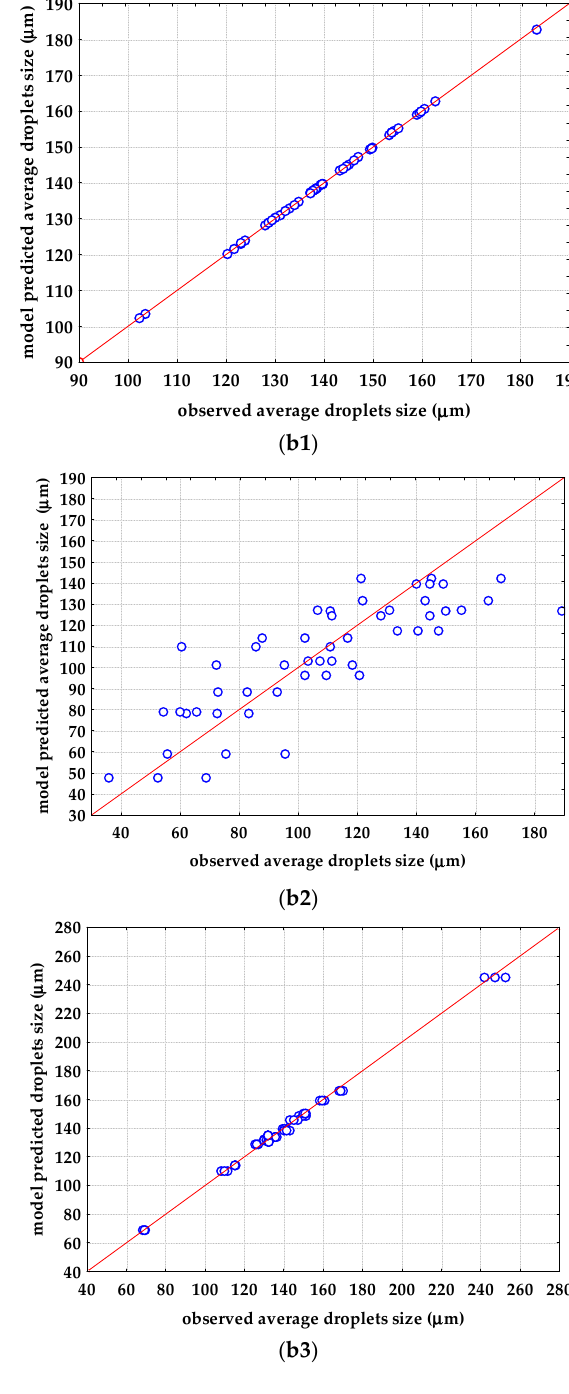
Figure 7. Comparisons between observations and ANN model predictions for the average droplets sizes of ( a ) oil-in-water emulsions and ( b ) oil-in-aqueous mint extract emulsions: ( a1 , b1 ) PEG 1500, ( a2 , b2 ) PEG 6000, ( a3 , b3 ) PEG 20,000.